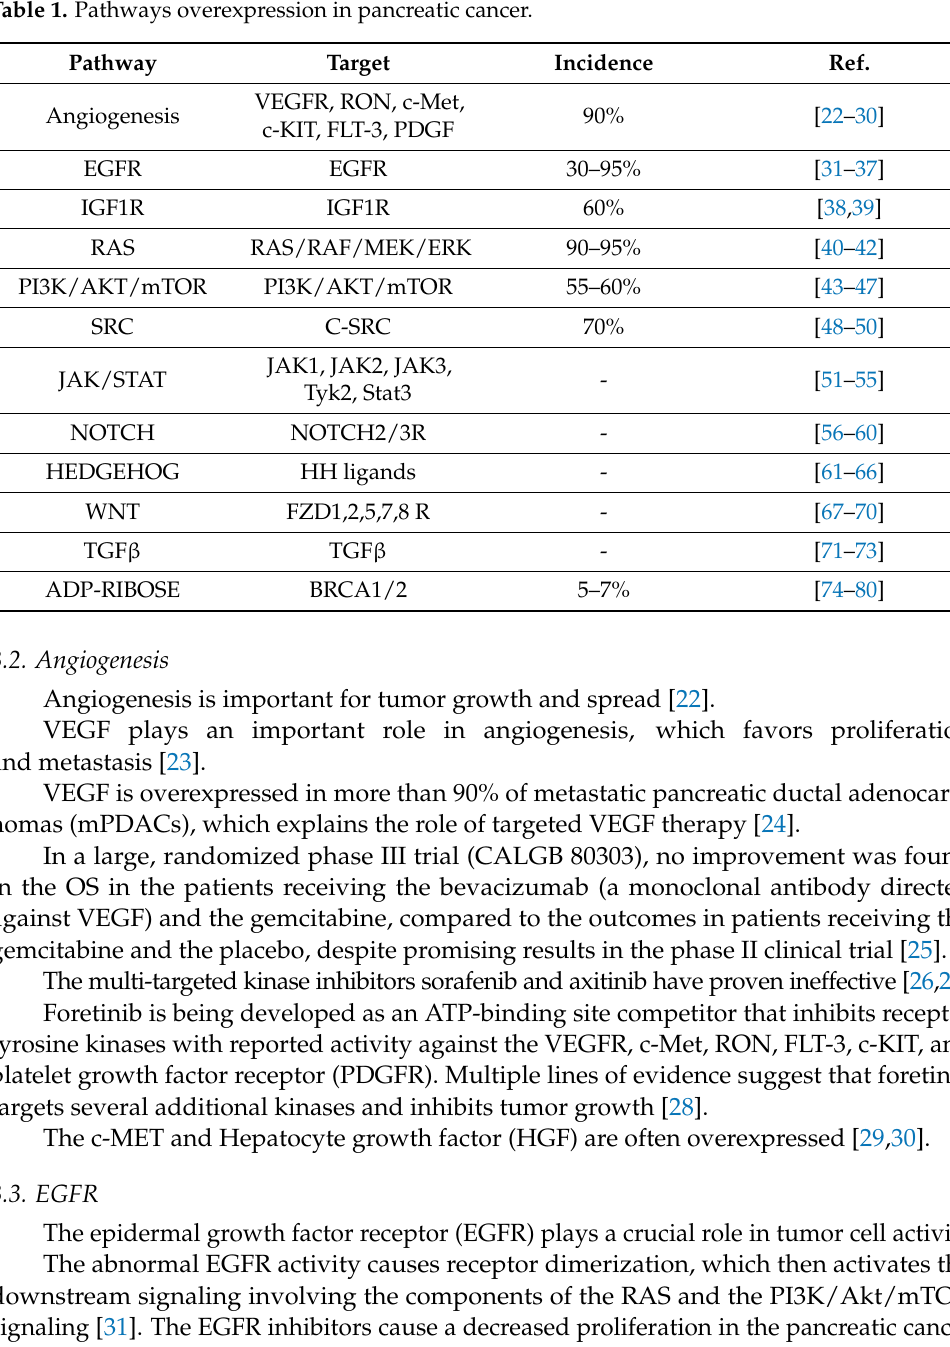
Table 1. Pathways overexpression in pancreatic